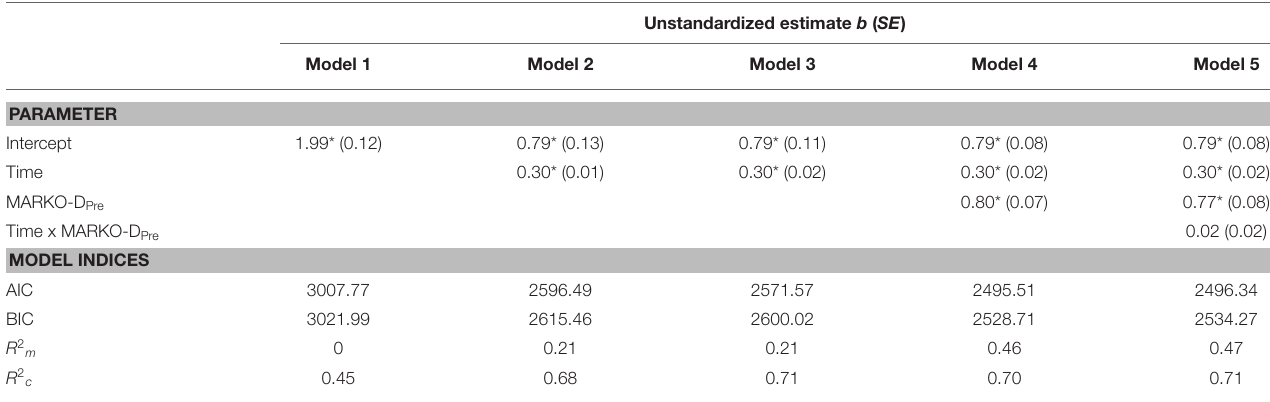
TABLE 5 | Fixed effects for mixed models predicting LPA performance ( N = 99 a